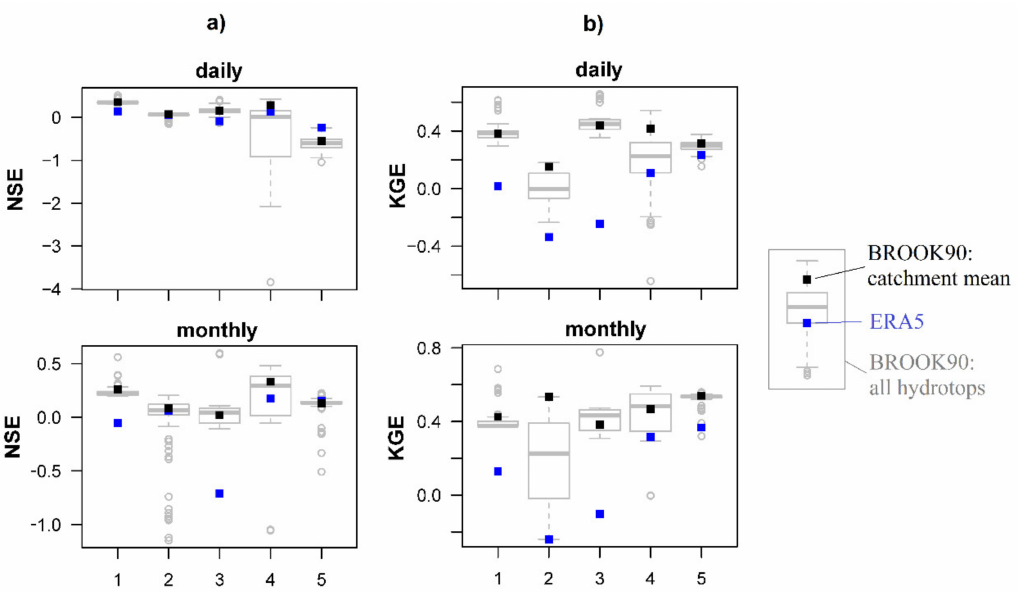
Figure 7. Validation with discharge data for the chosen catchments. Nash-Sutcli ff e E ffi ciency (NSE) ( a ) and Kling-Gupta E ffi ciency (KGE0 ( b ) for daily and monthly scales: all unique hydrotopes (boxplot) and catchment’s weighted mean (black square), ERA5 runo ff as an additional reference (blue